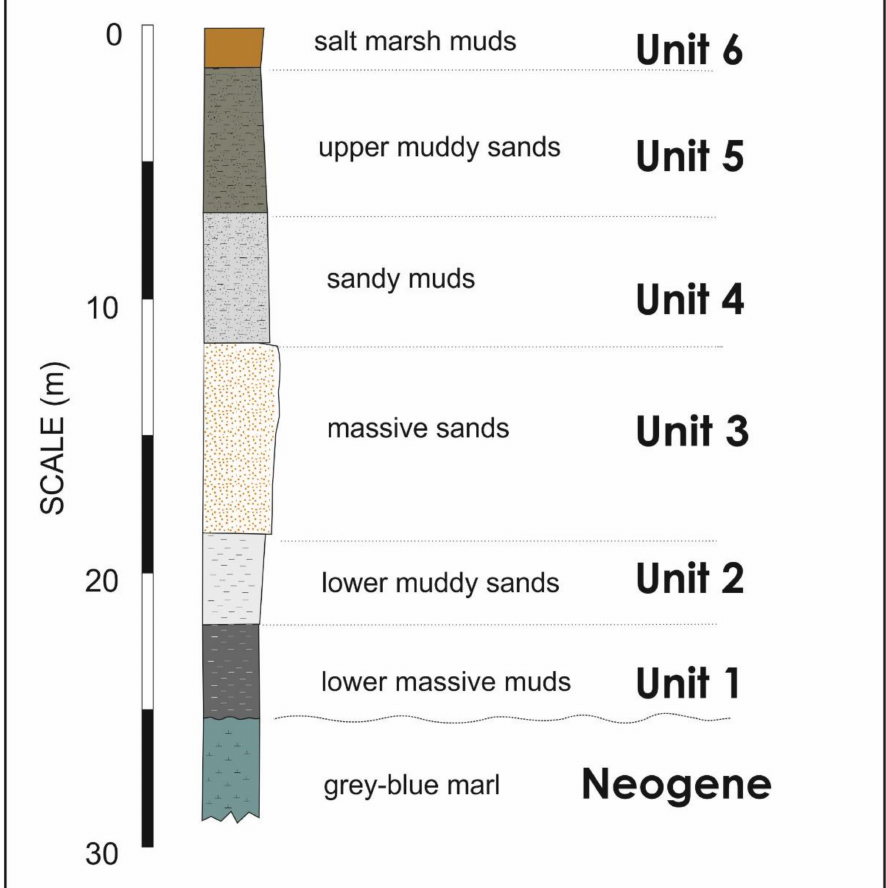
Figure 2. Holocene estuarine sequence of the central domain of the Tinto